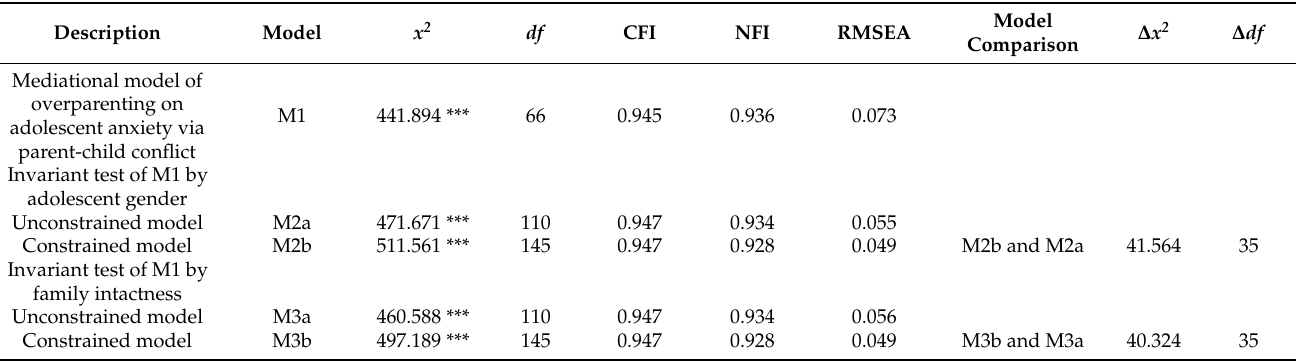
Figure 1. Cross-lagged model of the relationship among paternal and maternal overparenting, father-child conflict and mother-child conflict, and adolescent anxiety. * p < 0.05, ** p < 0.01, *** p < 0.001. Table 3. Cross-lagged panel analyses of mediating role of parent-child conflict between overparenting and adolescent anxiety and moderating roles of adolescent gender and family intactness.